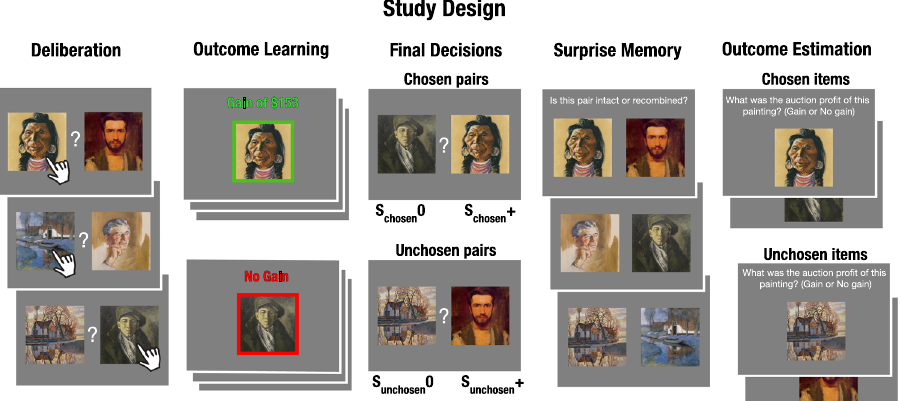
Fig. 1 Study design. In this multi-phase experiment, participants act as art dealers choosing paintings that are later sold in an auction. In the Deliberation phase, participants deliberate and decide which painting they would like to purchase to maximize their pro fi ts from the auction. After all decisions are made they learn the auction outcomes in the Outcome Learning phase. Only their selected paintings are presented alongside a colored frame and the pro fi t they made in the auction: either gain (green frame) or no gain (red frame). Then, in the Final Decisions phase, participants are given a choice between two paintings and are asked to choose the most valuable. Unbeknownst to them, the decision pairs are either two previously chosen paintings (rewarded and unrewarded in the auction, denoted as S chosen + and S chosen 0, respectively) or two previously unchosen paintings (initially presented with S chosen + and S chosen 0, denoted as S unchosen + and S unchosen 0, respectively). The two pair types are randomly intermixed. In the Surprise Memory phase, participants are tested for associative memory of the deliberation pairs. They are presented with either the exact pairs from the Deliberation phase (intact) or pairs that include chosen and unchosen paintings that were not previously presented together (recombined). Experiment 1 included an Outcome Estimation phase, wherein participants are asked to estimate the auction pro fi t of all paintings, including those they did not choose. Chosen and unchosen paintings are randomly intermixed. The study additionally included a pre-task and a post-task liking ratings of the paintings, detailed in the “ Method ” section. Stimuli were art images depicting people, objects, and scenes, randomly intermixed across conditions 77 . A subset of the stimuli are presented here. The art images in the fi gure include detailed images of the artworks PH-672 (1923), PP-241 (1936), and PH-269 (1941) by Clyfford Still, courtesy the Clyfford Still Museum, Denver, CO © 2021 City and County of Denver / ARS, NY, and the artworks Self Portrait (1900), A Farmbuilding (1900-1901), Farm